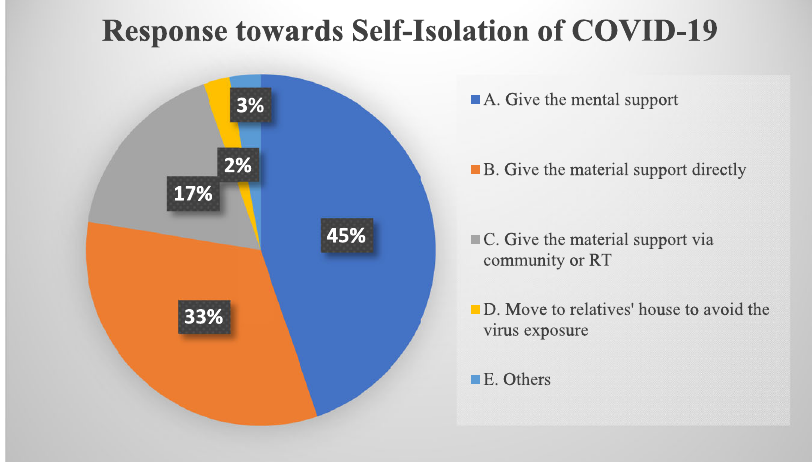
Fig. 1 Response towards self-isolation of COVID-19. Illustrates the results of a survey conducted via Google Forms regarding responses when fi nding neighbours, friends, and relatives undergoing independent isolation at home. The survey was compiled from 445 participants representing 27 provinces in Indonesia. The survey results show that as many as 45% of participants provide moral support to remain enthusiastic during self-isolation through communication, suggestions and advice. 33% provided material assistance (groceries, food, vitamins, supplements, fruit) independently directly to those undergoing self-isolation. 17% provided material assistance (groceries, food, vitamins, supplements, fruit), organised collectively through the RT or community. 3% perform other actions, such as praying. The remaining 2% chose to move temporarily to a relative ’ s house or another place to avoid